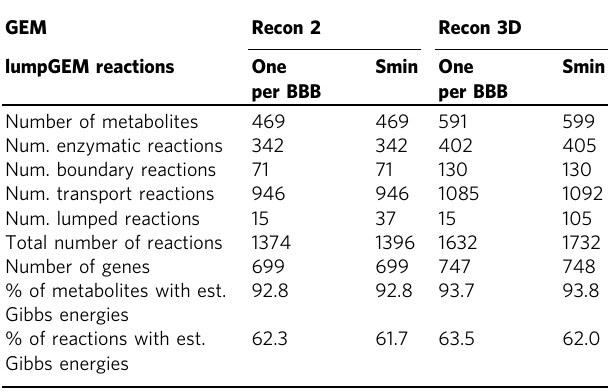
Table 1 Statistics on the generated reduced metabolic